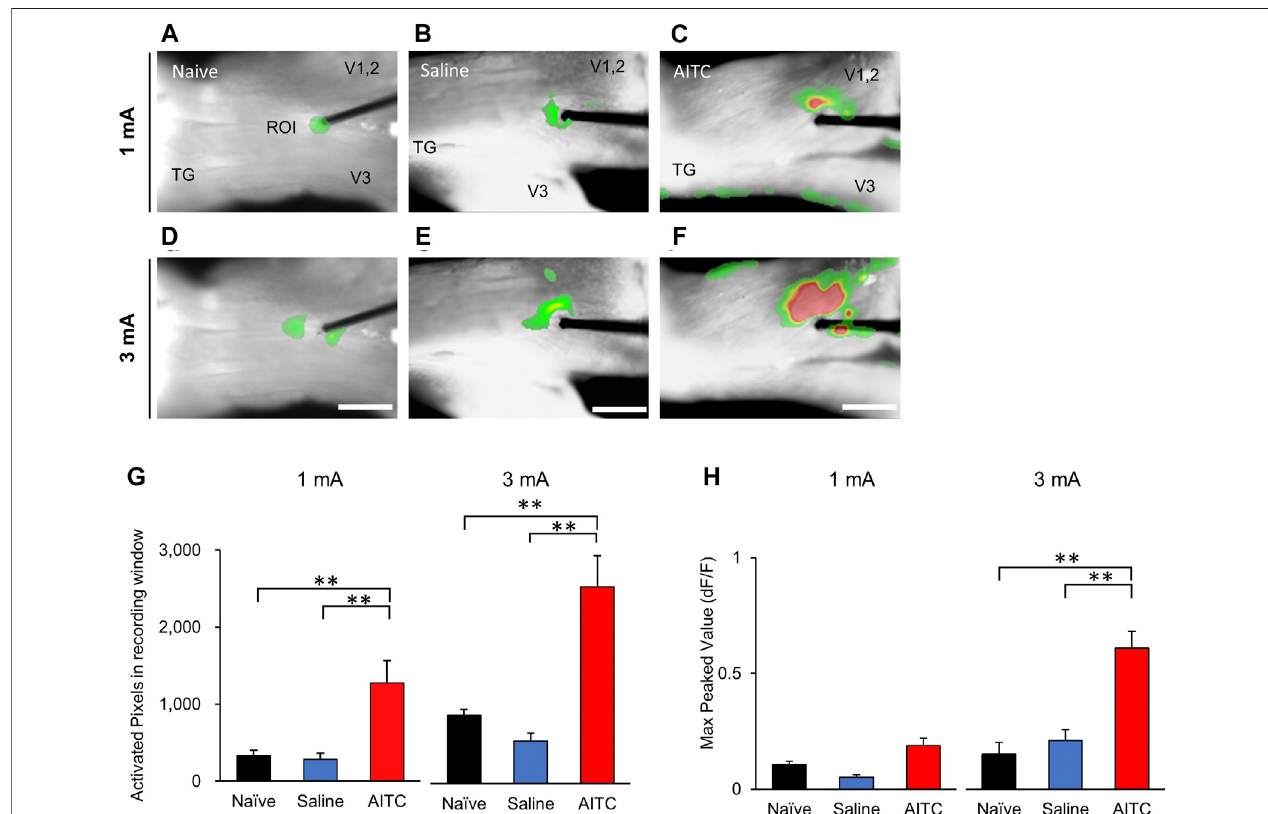
FIGURE4| Pulpitis-inducedhyperactivitiesinTG.Comparisonofopticalsignalsat1 (A – C) and3 mA (D – F) stimulationinthenaïve (A,D) ,saline-treated (B,E) ,and AITC-treated (C,F) TGs.In theAITC-treatedTGs,stimulus-dependent enlarged optical signals wereobserved. (G) Activated pixels wereanalyzedindifferent intensityof stimulation. (H) Max peaked values after stimulation were analyzed. Compared to naive and sham, more activated pixcels and higher peak activity were observed in AITC-treated group (Error bars represent SEM; ** p < 0.01).